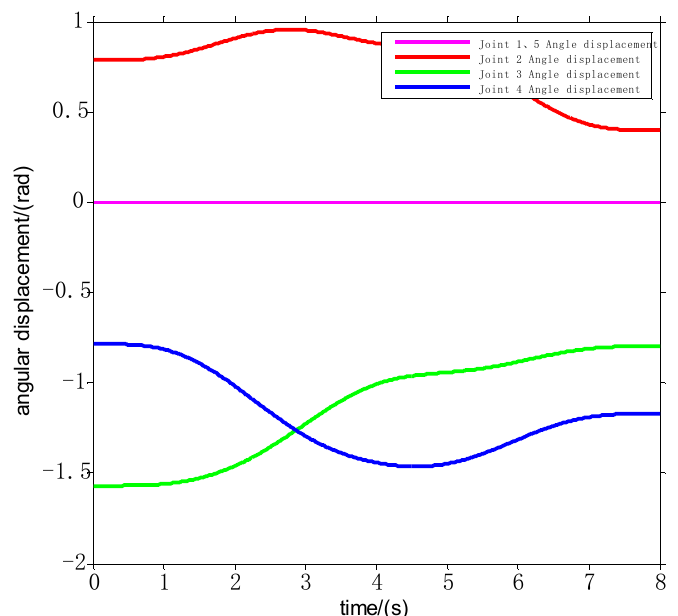
Figure 9. Spatial angular displacement of the robot joint.